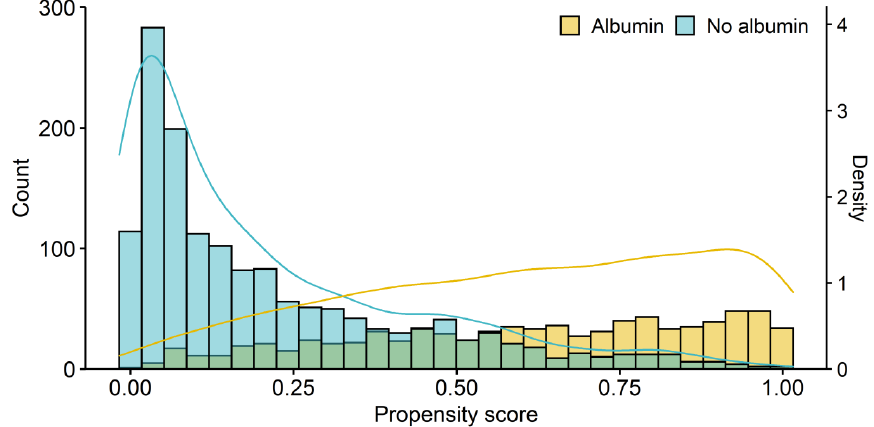
Int. J. Mol. Sci. 2023 , 24 , x FOR PEER REVIEW Figure 3. Distribution of propensity scores for patients in the albumin and no-albumin groups. Table 1. Demographic and clinical characteristics in the unadjusted and adjusted cohorts.